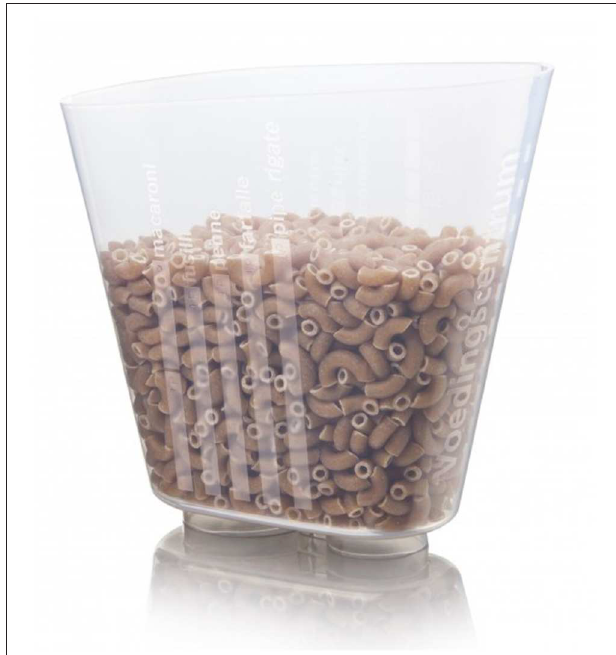
FIGURE 2 | Measuring cup containing